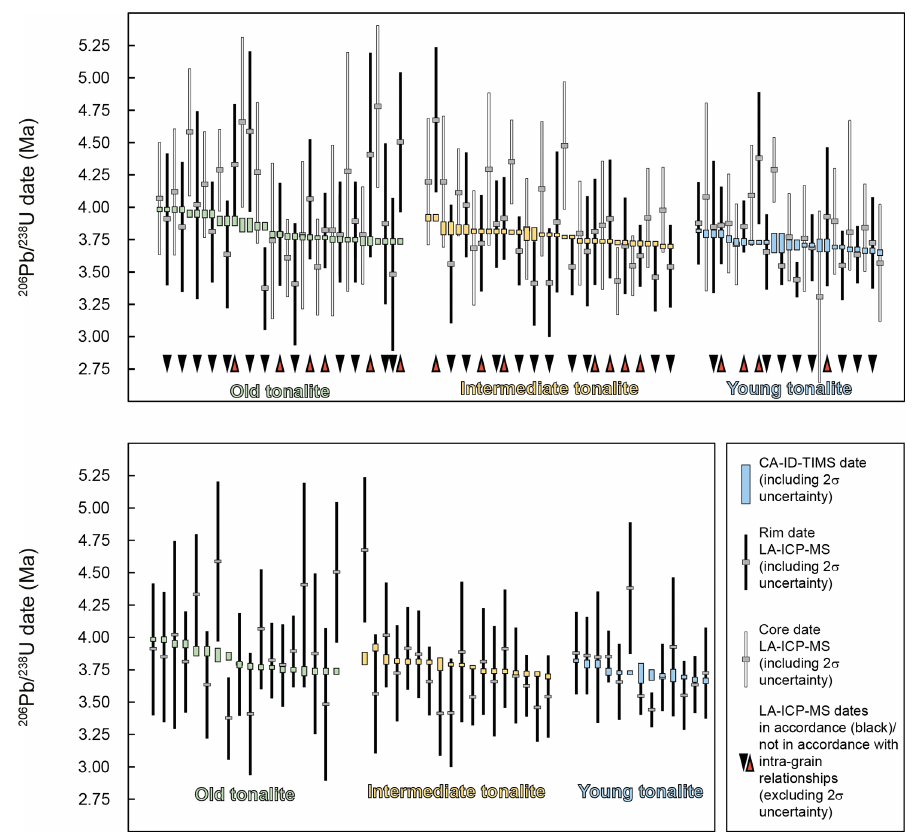
Figure 10. Comparison of in situ LA-ICP-MS dates and CA–ID–TIMS dates on the same zircons. In the upper panel each CA–ID–TIMS date is aligned with the rim (filled) and core (empty) LA-ICP-MS date of the same zircon. Coloured bars indicate individual CA–ID–TIMS analysis, including analytical uncertainty (2 σ ). Downward-pointing black arrows indicate that core analyses are older than rim analyses of the respective zircon, whereas upward-pointing red arrows indicate the opposite. Note that CA–ID–TIMS dates can be plotted several times, with core and rim analyses of the same zircon. The lower panel compares the CA–ID–TIMS date with the respective rim analysis.